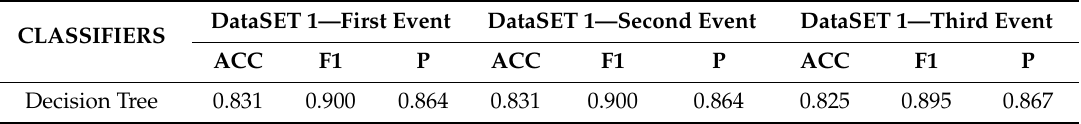
Table 7. Final result of the